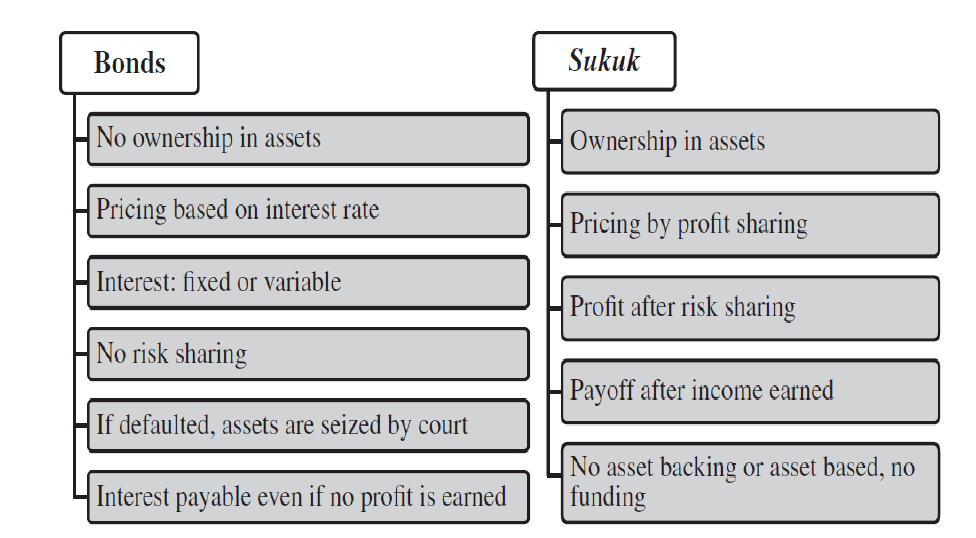
Figure 3- Fundamental Principles of Sukuk Security Compared to Conventional Debt